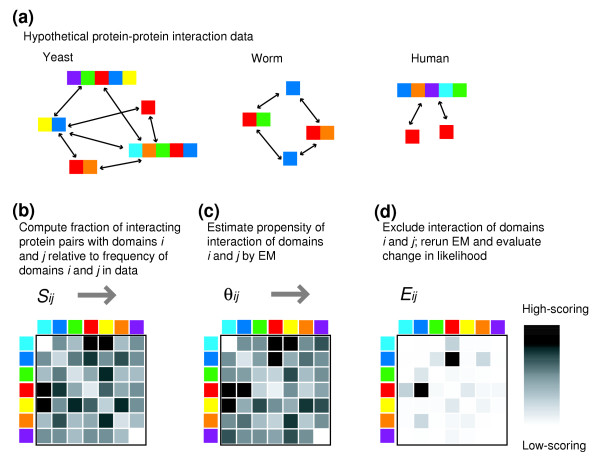
Overview of DPEA method. (a) In this hypothetical protein interaction dataset, domains are represented as colored squares; proteins are represented as collections of one or more domains joined together; and protein interactions are shown as black double arrows. The protein interactions are known, the domain content of each protein is known, and domain interactions are unknown. Any pair of domains that co-occur in a pair of interacting proteins is considered a potentially interacting domain pair. (b) The frequency of proteins with domain i interacting with proteins with domain j, Sij is computed. (c) Using Sij as an initial guess, the propensity, θij, of each kind of potential domain interaction is estimated by EM. (d) The evidence, Eij, for each inferred domain interaction is then assessed by calculating the change in likelihood when a given type of domain interaction is excluded.